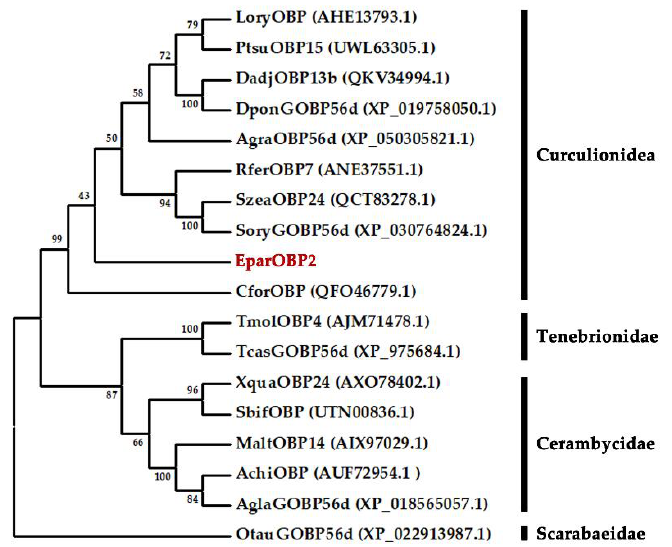
Figure 3. Phylogenetic tree of EparOBP2 amino acid sequences with OBP from other coleopteran insect species. The tree was constructed using the neighbor-joining method with a bootstrap of 1000 replicates. OtauOPB from Onthophagus taurus (Coleoptera: Scarabaeidae) was used as an outgroup to root the tree. Anoplophora chinensis (Achi), Anthonomus grandis (Agra), Anoplophora glabripennis (Agla), Cylas formicarius (Cfor), Dendroctonus ponderosae (Dpon), Dendroctonus adjunct (Dadj), Lissorhoptrus oryzophilus (Lory), Monochamus alternatus (Malt), Onthophagus taurus (Otau), Pagiophloeus tsushimanus (Ptsu), Rhynchophorus ferrugineus (Rfer), Sitophilus oryzae (Sory), Sitophilus zea- mais (Szea), Semanotus bifasciatus (Sbif), Tribolium castaneum (Tcas), Tenebrio molitor (Tmol), Xylotrechus quadripes